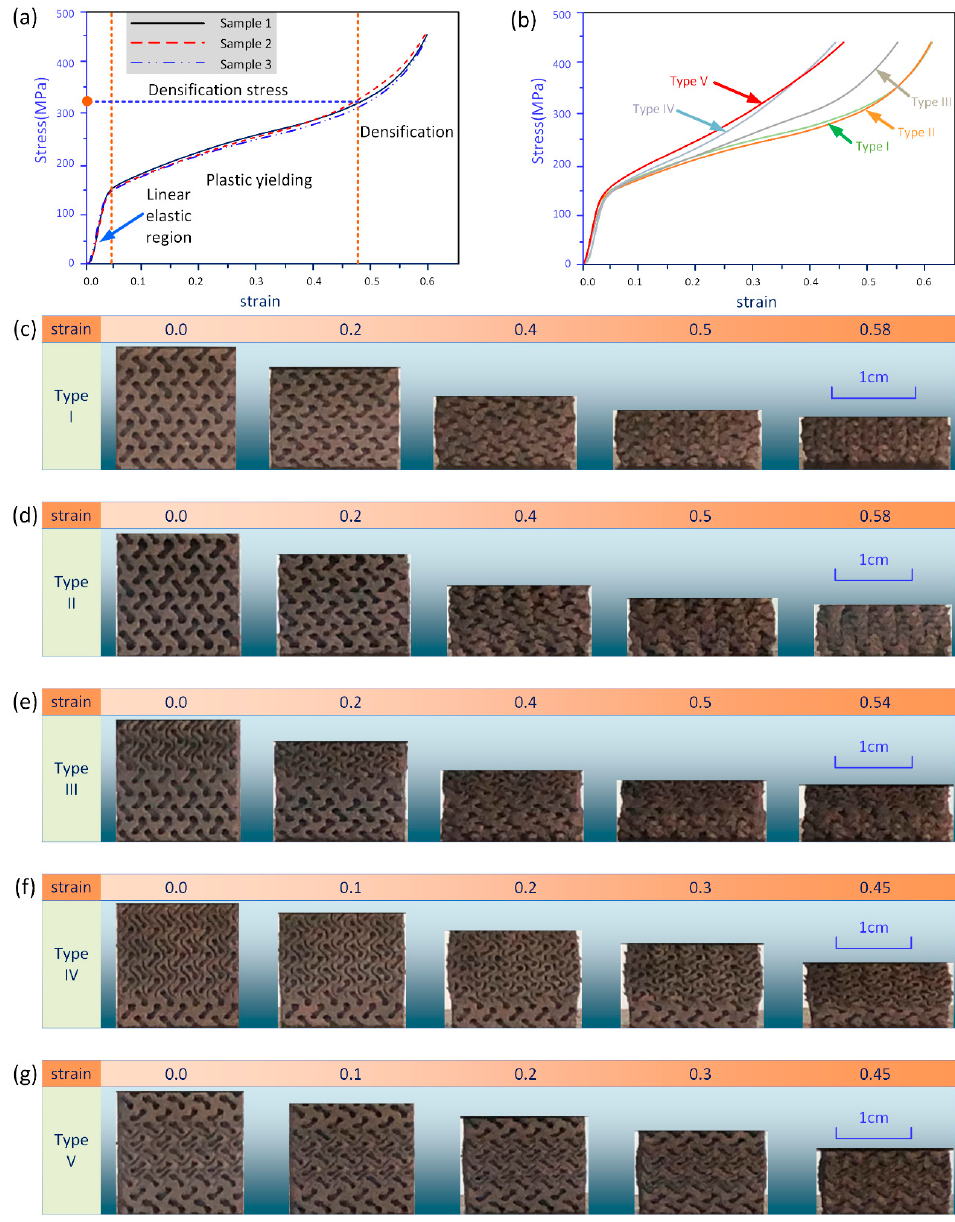
Figure 7. Stress–strain response and compressive behavior of specimens with different design: ( a ) illustration of the obtained stress–strain curve of one design; ( b ) obtained stress–strain curves of five different designs; and ( c – g ) compression deformation of different types of specimens.